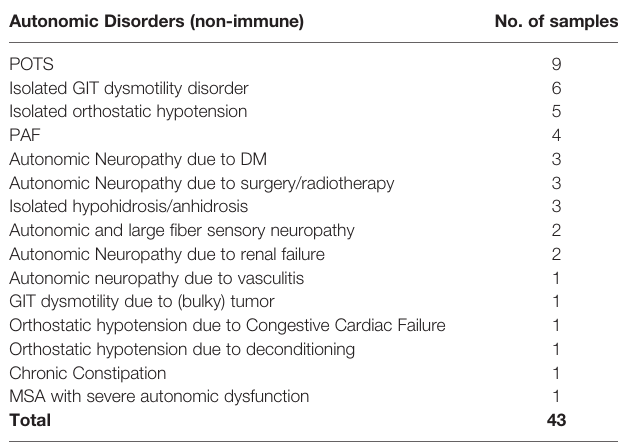
TABLE 2 | Clinical diagnoses of samples from subjects with a range of disorders with autonomic dysfunction, but not thought to be autoimmune autonomic ganglionopathy. Autonomic Disorders